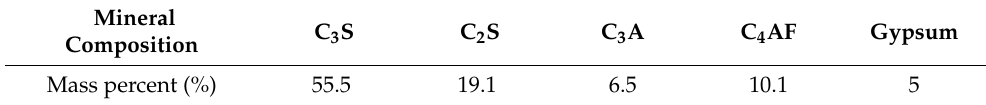
Table 5. Chemical composition of P.O.42.5 ordinary portland cement.